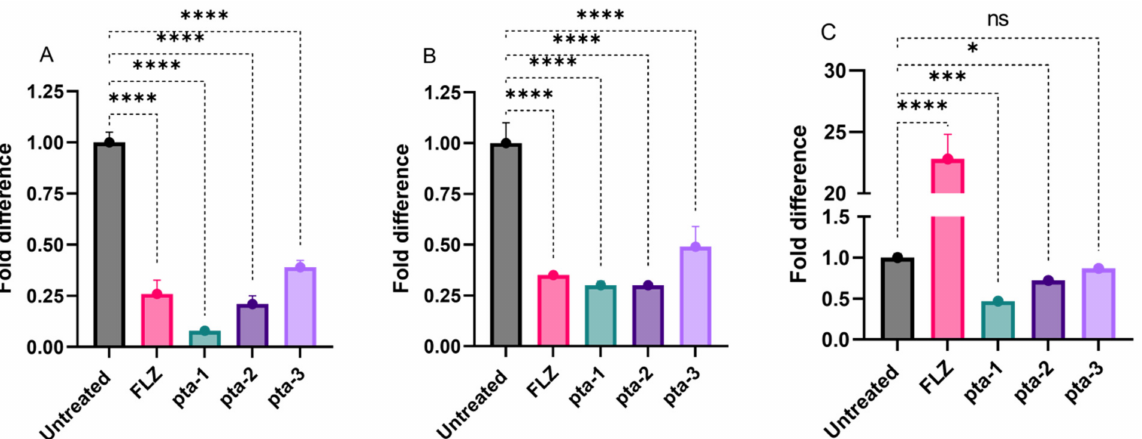
Figure 6. Quantification of ERG11 gene expression after normalization to ACT1 in different C. albicans strains after exposed to inhibitory concentrations of pta-1, pta-2, and pta-3. ( A ). C. albicans SC5314. ( B ) C. albicans 4175. ( C ) C. albicans 5112. Results are the mean ± SD of three different readings. Bars with asterisks indicate significant differences as follows (*** p < 0.001). **** p < 0.0001; *** p = 0.002; * p = 0.0171; ns indicates non-significant =